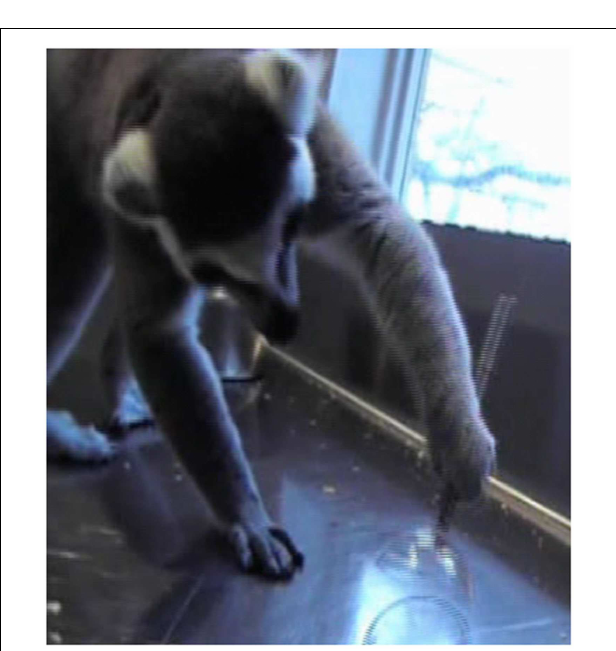
FIGURE 7 |A ring-tailed lemur grasping an inverted cup’s stem using a thumb-down posture .The lemur then inverted the cup to remove a raisin from it. (Image from Chapman et al.,